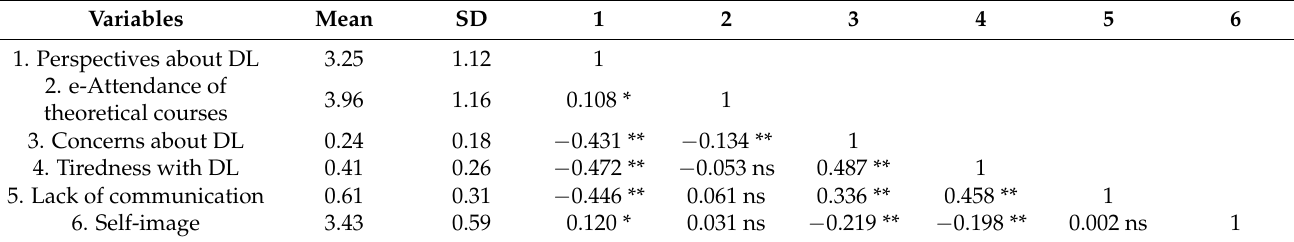
Table 2. Means, standard deviations, and correlations (Spearman’s correlation coefficient rho ( ρ )) of the variables perspectives on distance learning (DL), e-attendance of theoretical courses, concerns about distance learning, tiredness with distance learning, lack of communication during the distance learning, and